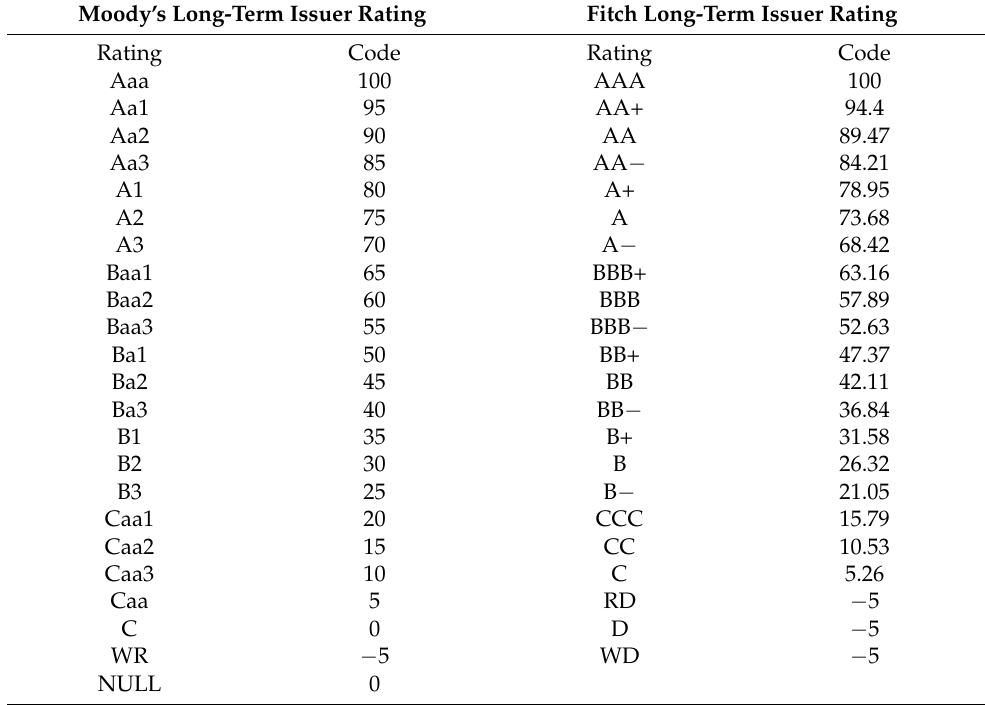
Table 3. Decomposition of Moody’s and Fitch long-term issuer credit